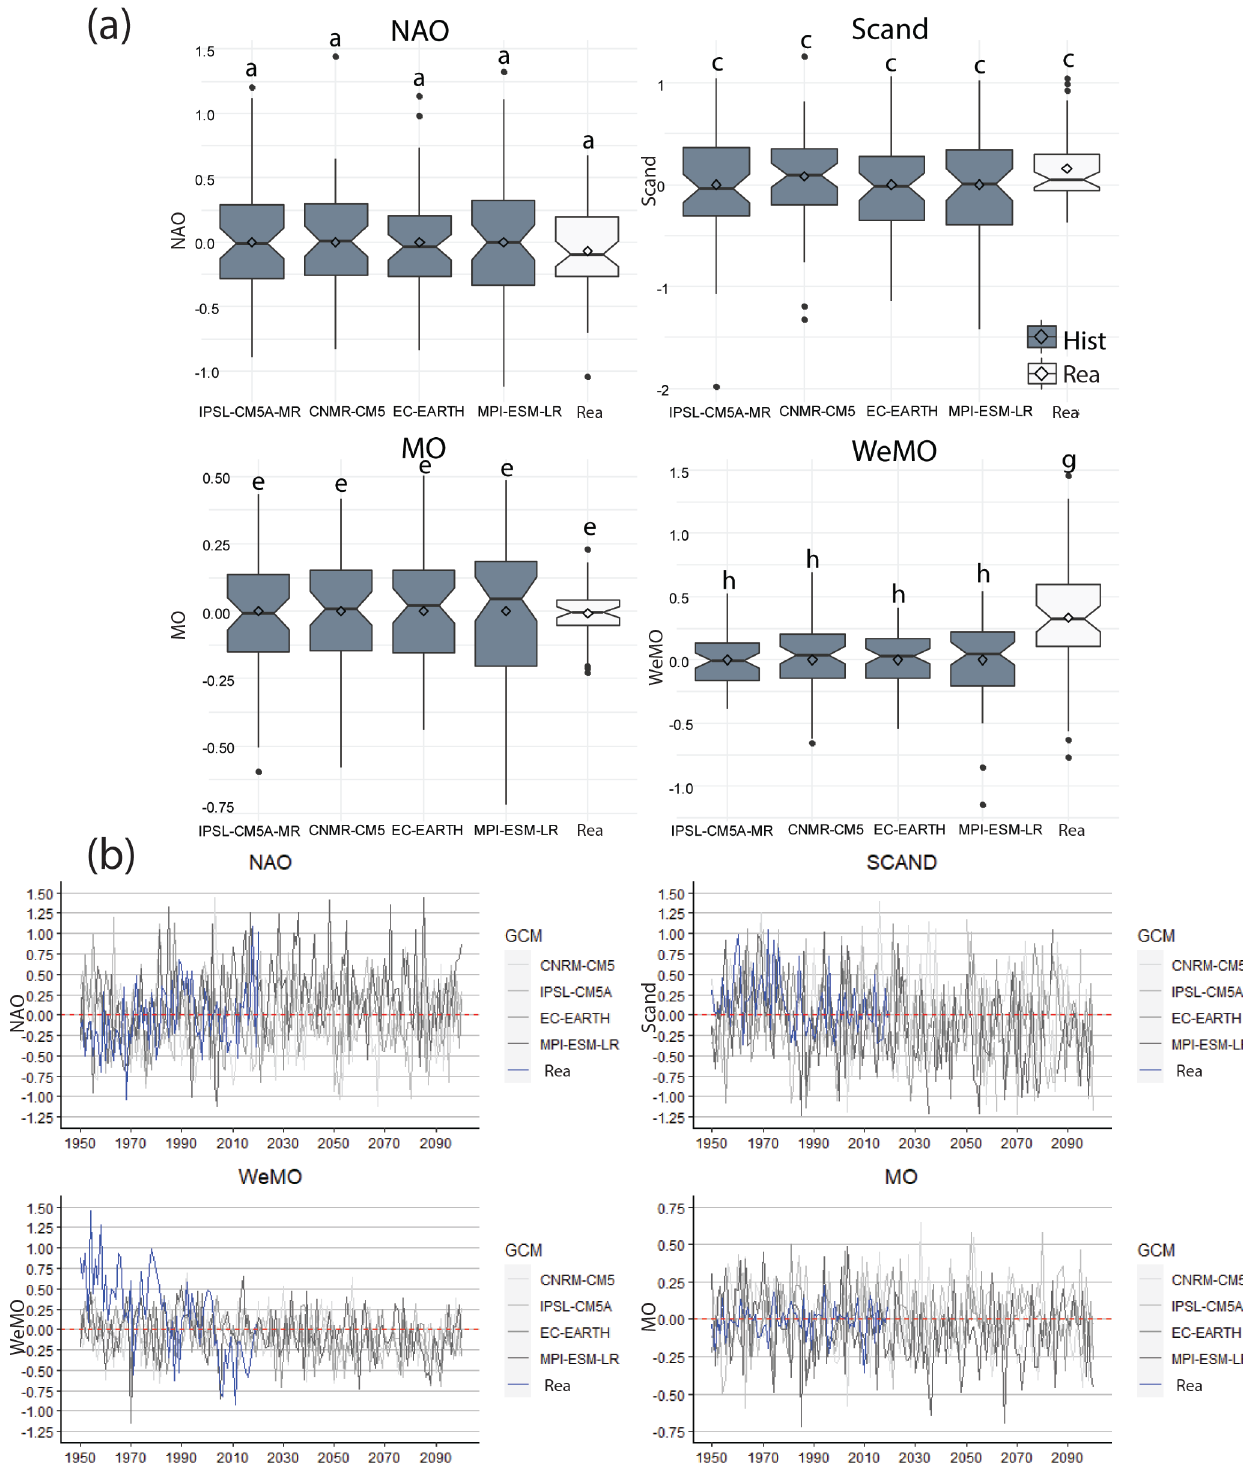
Figure 4. Evolution of the annual teleconnection pattern. (a) Variability of teleconnection patterns provided by the reanalysis for the period 1950–2005 (Rea) and simulated by the four GCMs in the historical period 1950–2005 (Hist). Letters indicate whether box plots are signif- icantly equal (same letter as box plot “Rea”) or not. (b) Annual future projections under a RCP8.5 scenario. The blue line represents the annual reanalysis data and is referred to as “Rea” in the